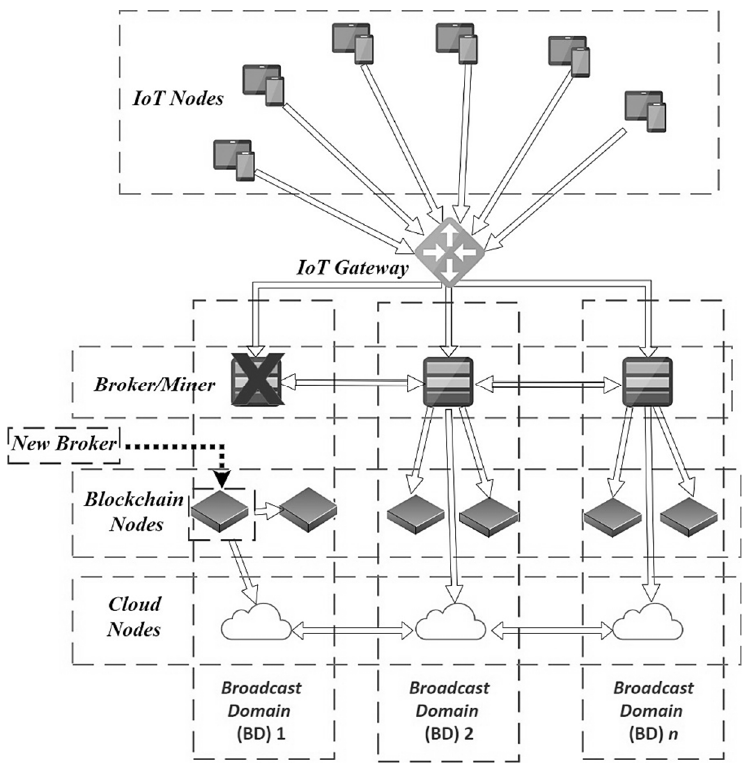
Figure 4. The broker on BD 1 failed, and thus, one node becomes the new broker. The Broker outside can be selected if all nodes on the failed Broadcast Domain are down or when there are attacks on a failed Broadcast Domain. A Failed Broadcast Domain is discovered by the Application when the Application is unable to communicate with the broker and all nodes in a particular Broadcast Domain. The application will mark the Broadcast Domain as failed if it cannot communicate with the broker and all nodes in it. The new Broker will have the blockchain for the failed Broadcast Domain because it has Cloud Nodes which are members of all Broadcast Domains. Figure 5 shows that the Broker on Broadcast Domain 2 (BD2) becomes the new broker for Broadcast Domain 1 (BD1), which failed due to attacks. The broker from Broadcast Domain 2 (BD2) becomes the new broker and will have the database from Broadcast Domain 1 (BD1), because it has Cloud nodes that are a member of all Broadcast Domains. The Cloud Node on Broadcast Domain 1 (BD1) and Broadcast Domain 2 (BD2) are one entity with two or more nodes in the same cluster. The Application will select a broker from Broadcast Domain nearest to the IoT nodes or users to become the new broker for the failed Broadcast Domain.